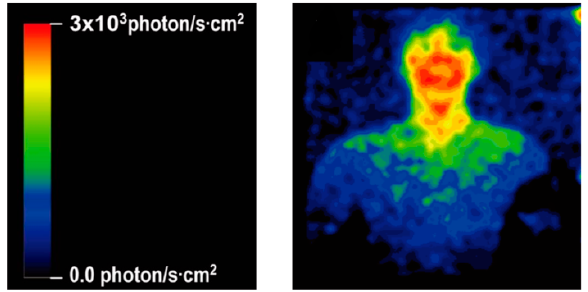
Figure 7. The glow of the human body.